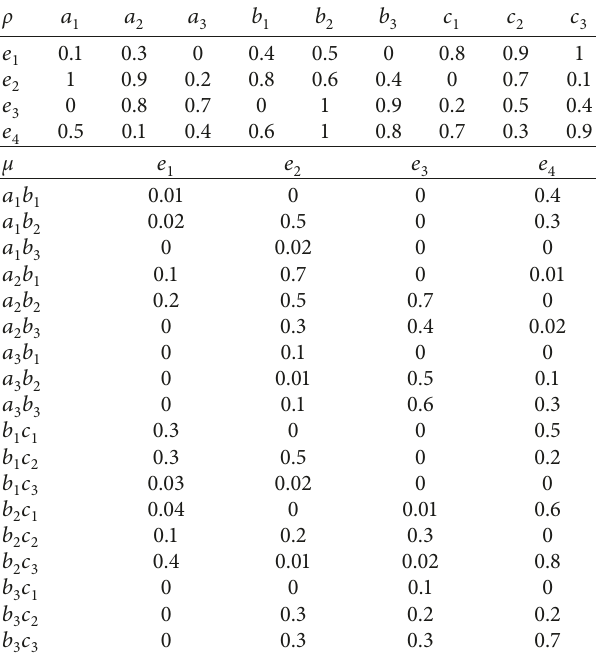
Table 3: Relation between vertices and parameters of perfect fuzzy soft tripartite